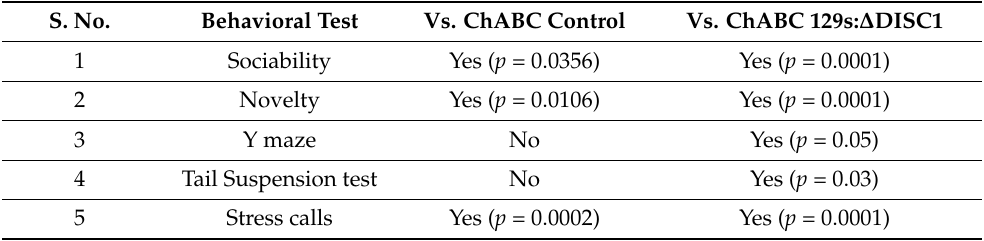
Table 1. Summary of the behavioral tests. All results are shown as compared to a penicillinase-control group. S.